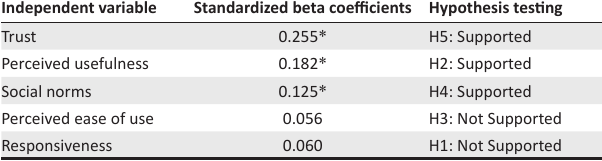
TABLE 4: Multiple regression analysis of OBC continuance intention. Independent